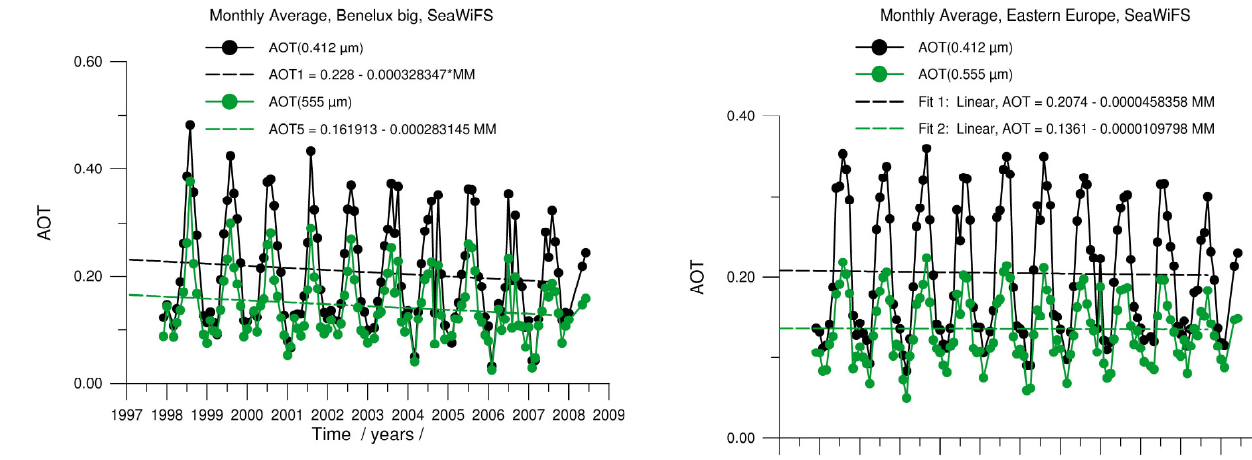
Fig. 22a. Time series of AOT for SeaWiFS channel 1 (0.412µm) and channel 5 (0.555µm) for the time span October 1997–May 2008 for the selected regions of interest: BeNeLux-big (Fig. 22a), Po- Valley-big (Fig. 22b), Eastern Europe (Fig. 22c) and Pearl River Delta (Fig. 22d). Linear fits for the trends of the retrieved AOT are presented as dashed lines.